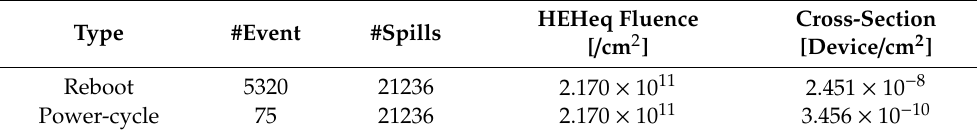
Table 1. Average reboot and power-cycle events and their